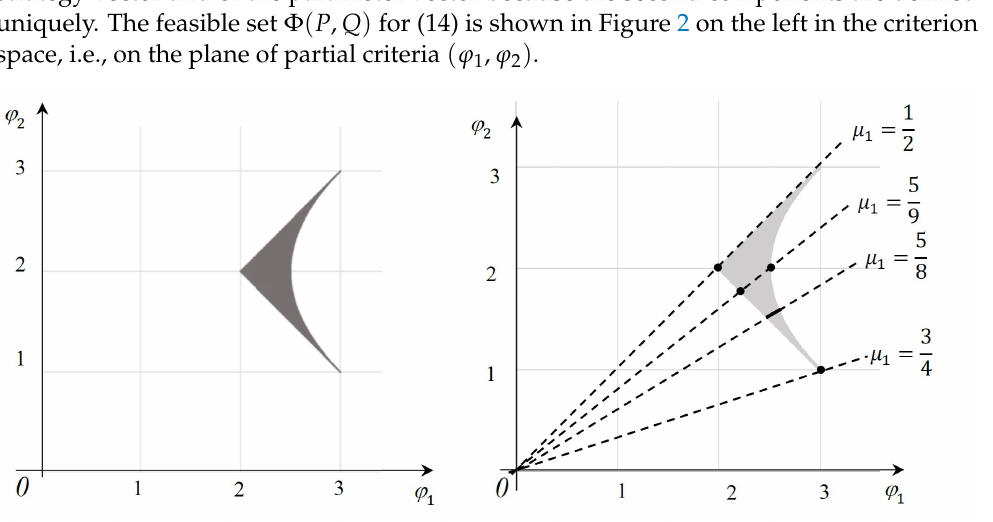
Figure 2. Game (14). Criterion space with the feasible set Φ ( P , Q ) (on the left) and the sets of equilibrium values (in bold) for scalar games Γ G ( µ ) , µ = 1/2, 5/8, 5/9, and 3/4 (on the right). For µ = ( 1/2, 1/2 ) , the unique outcome ( p 1 = 1, q 1 = 0 ) is the equilibrium in the game Γ ( 1/2, 1/2 ) . The corresponding equilibrium value is equal to (2, 2), i.e., Z ( 1/2, 1/2 ) G